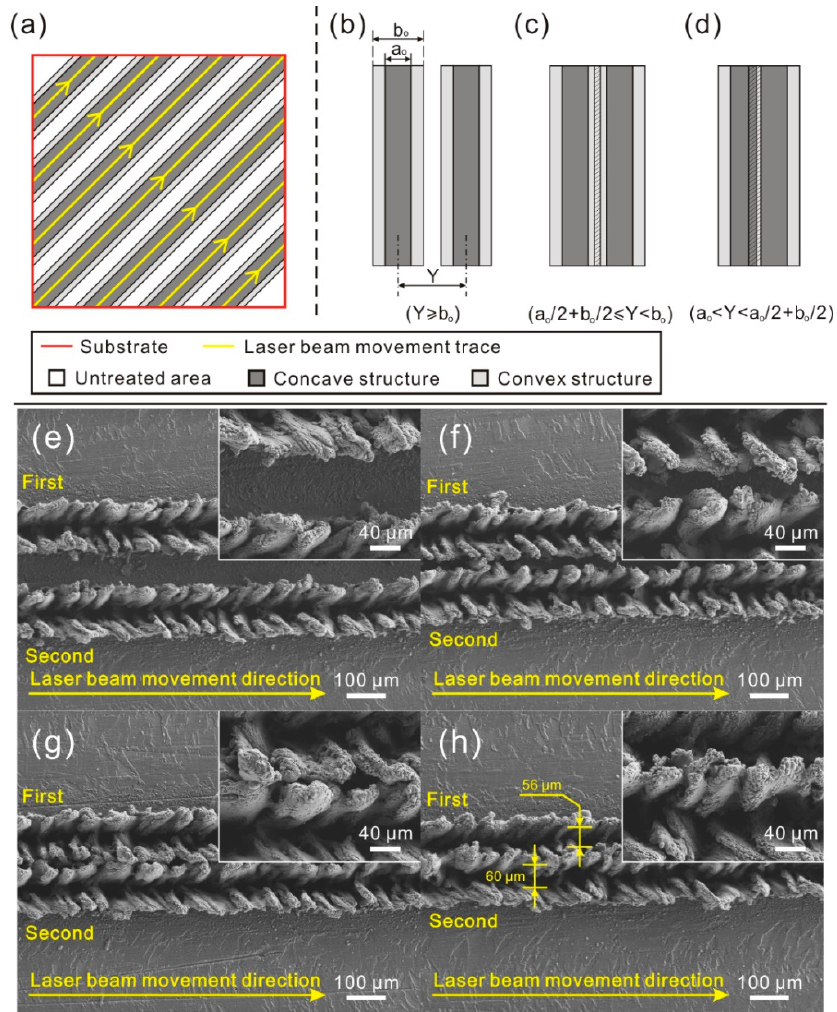
Figure 8. ( a ) Schematic of laser beam movement trace during laser micro-engraving; ( b – d ) relationship between microstructure and texture spacing; ( e – h ) SEM image of the strip microstructure with different texture spacing (laser beam pulse frequency of 6000 Hz, laser beam scanning speed of 0.15 m/s).